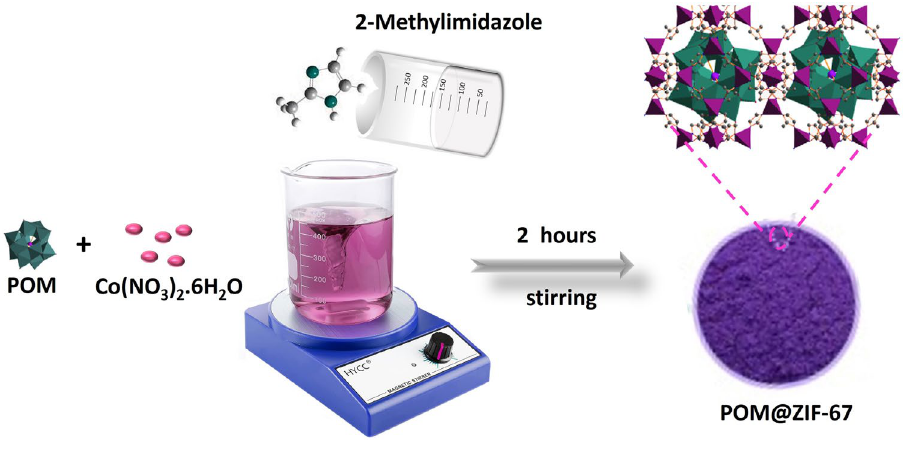
Figure 1. Stepwise Synthesis of